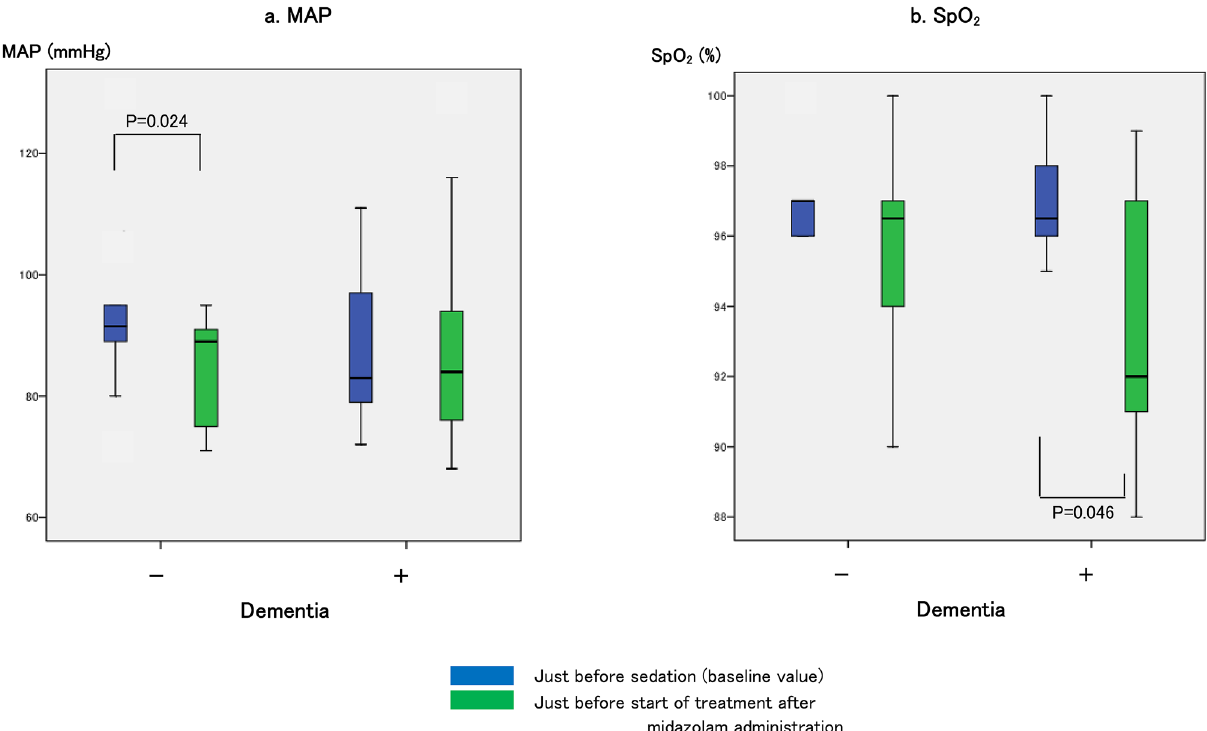
Figure 3. Changes in the mean arterial pressure (MAP) and percutaneous arterial oxygen saturation (SpO 2 ). ( a ) indicates the MAP values: 91.5 (86.8–97.5) mmHg just before sedation and 89 (74.5–91) mmHg just before the start of treatment after midazolam administration ( P = 0.024) in the dementia-negative group; 83 (78.5–99.3) mmHg just before sedation and 84 (74.5–99.5) mmHg just before the start of treatment after midazolam administration in the dementia-positive group. ( b ) indicates the SpO 2 values: 97% (96–97) just before sedation and 96.5% (93.8–97.3) just before the start of treatment after midazolam administration in the dementia- negative group; 96.5% (96–98) just before sedation and 92% (90.5–97.5) just before the start of treatment after midazolam administration ( P = 0.046) in the dementia-positive